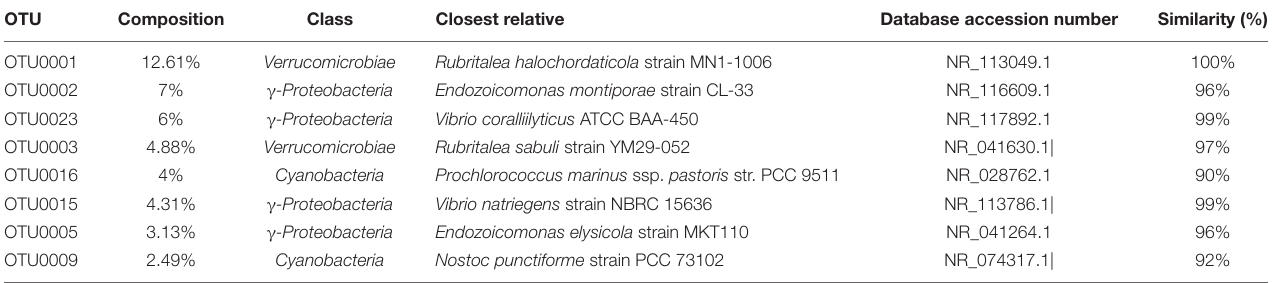
TABLE 1 | (A) Affiliation of bacterial sequences retrieved from coral mucus samples. OTU Composition Class Closest relative Database accession number Similarity (%)